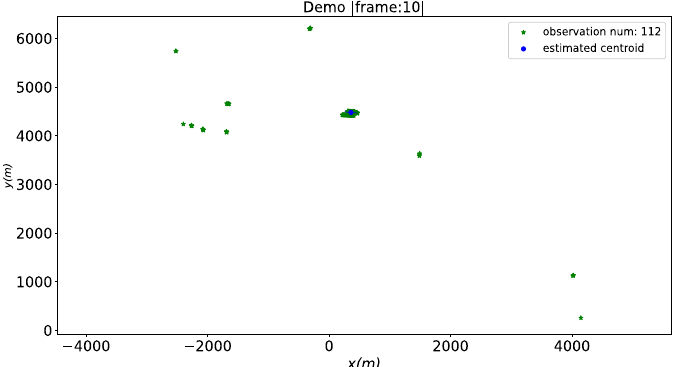
Figure 7. Single target in the Cartesian coordinate system tracking in the 10th frame.